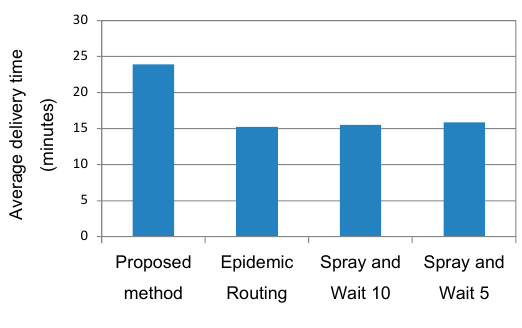
Figure 12. Average delivery time.